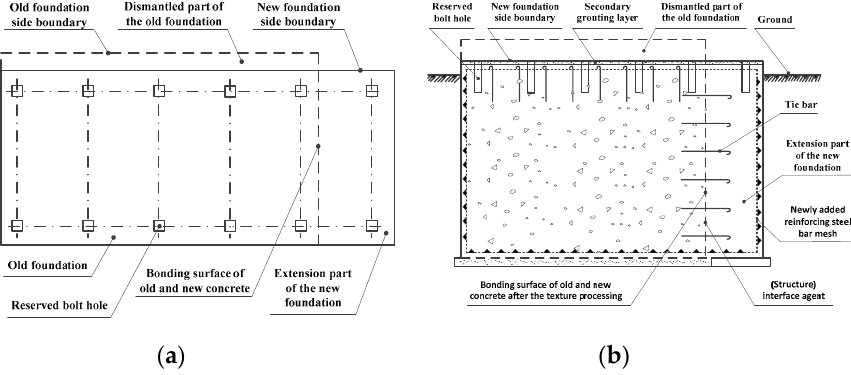
Figure 3. A composite foundation composed of old and new concrete [13]. ( a ) Top view; ( b ) longitudinal section.